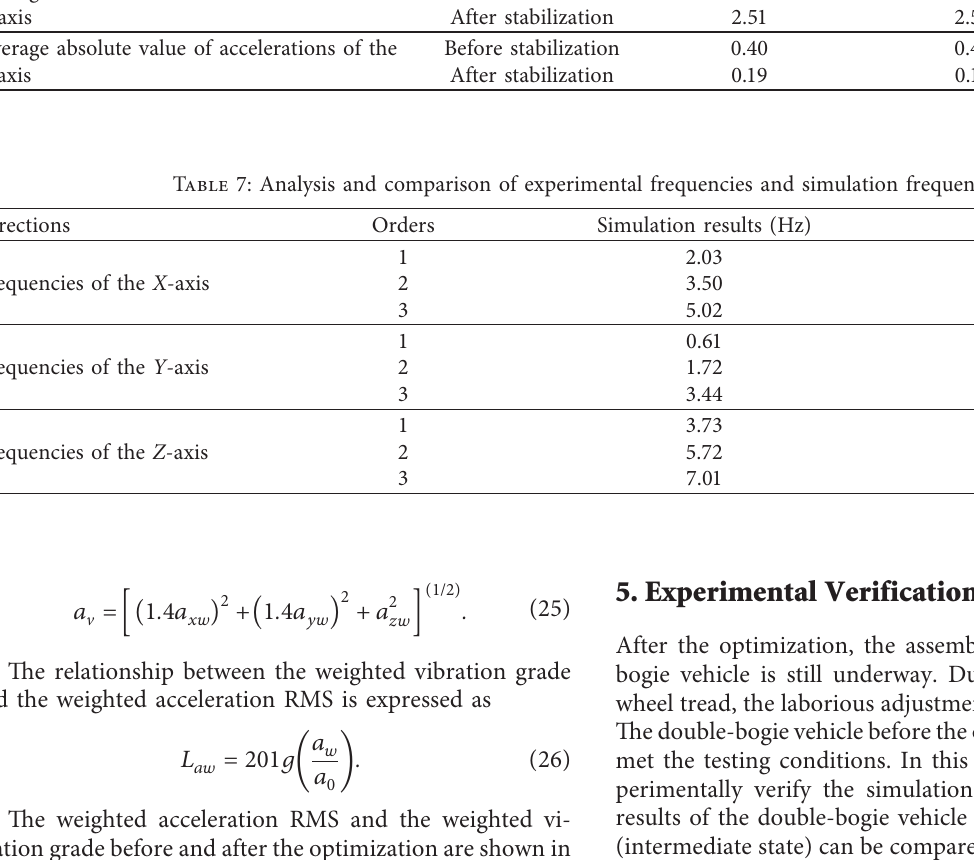
Table 6: Analysis and comparison of experimental acceleration and simulation acceleration. Directions Average absolute value of accelerations of the X -axis Average absolute value of accelerations of the Y -axis Average absolute value of accelerations of the Z -axis